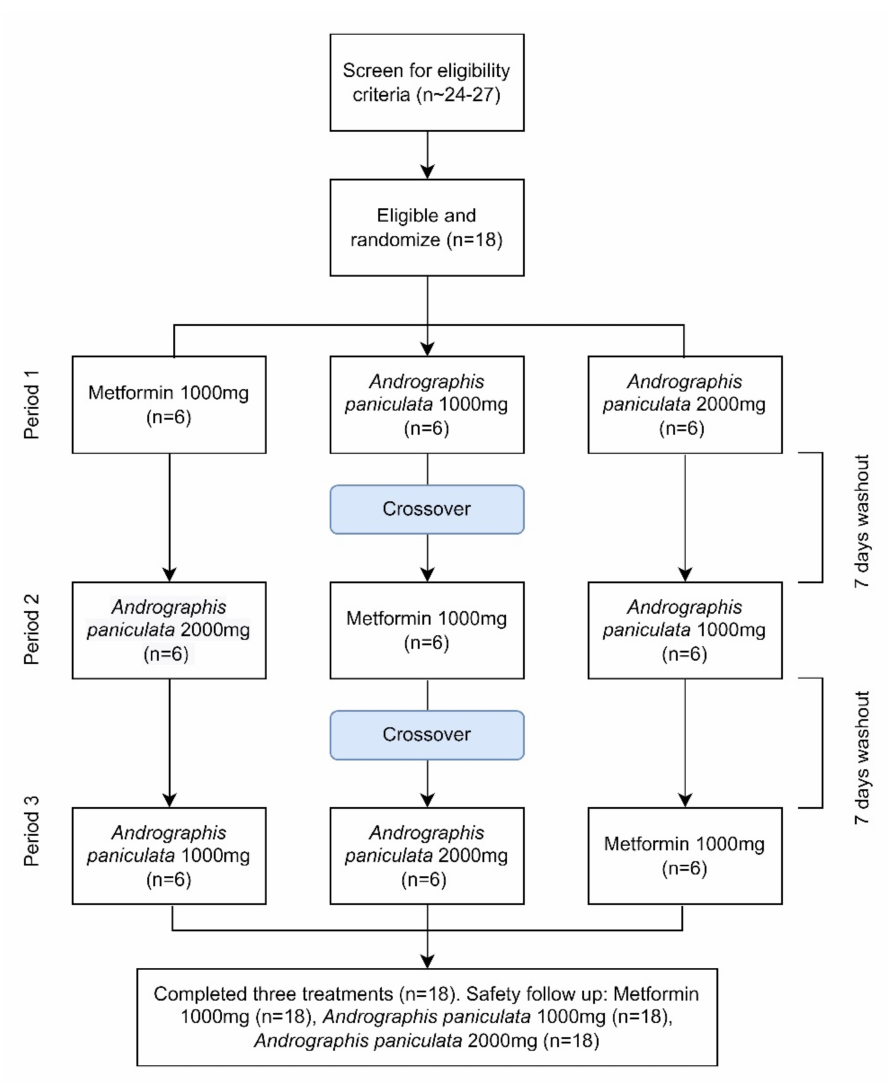
Figure 1. Crossover, three—treatments, three—period clinical trial study